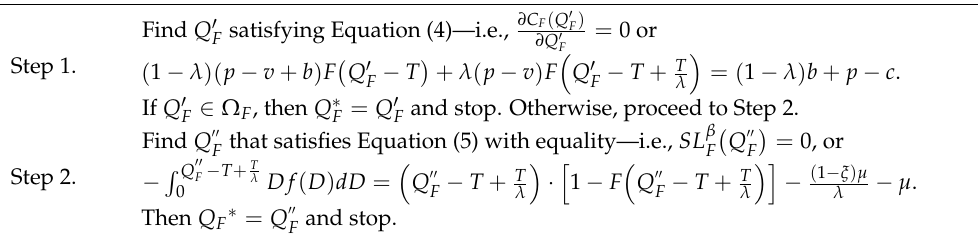
Algorithm 1. Determining the optimal order quantity when the demand distribution is